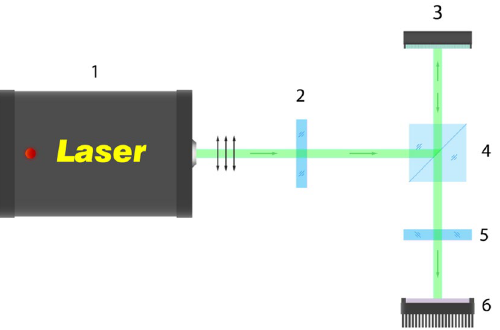
Figure 6. Optical scheme for studying the dependence of the rotation of the polarization angle on the grayscale level at the SLM input: (1) a laser with linearly polarized light; (2) half-wave plate; (3) LCoS SLM; (4) beam- splitting cube; (5) analyzer; (6) laser power meter.